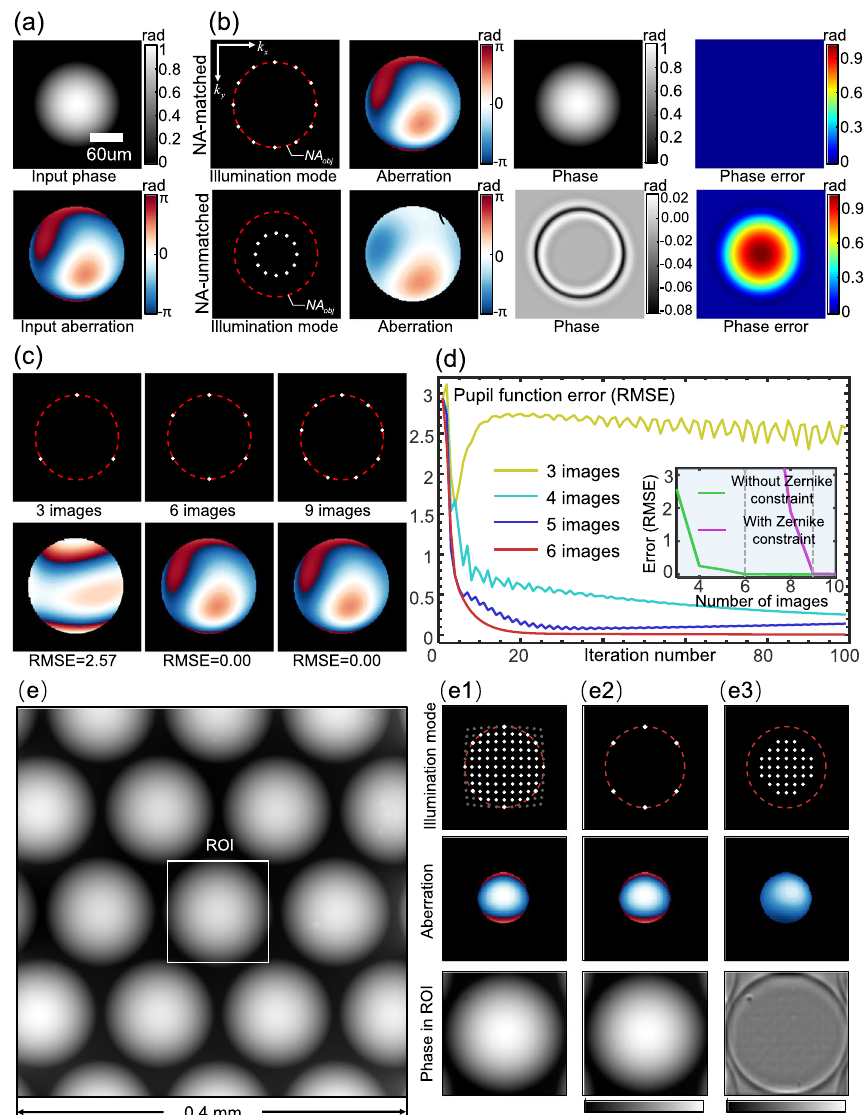
Fig. 2 Reconstructed phase and aberration under different illumination modes. (a) Simulated specimen phase (above) and aberration (below). (b) Reconstructed results with and without matched illumination, including illumination modes of the LED array (the red circle is NA of the objective lens), recovered aberrations, recovered phase and corresponding phase error. (c) Reconstructed results with 3, 6, 9 images. (d) Convergence curves of the reconstruction with different number of images. (e) Reconstructed phase of microlens in the full FOV. (e1) Experiment result of ROI using full 121 images. (e2) Experiment result of ROI using 6 images under the matched illumination. (e3) Experiment result of ROI using 37 images without the matched